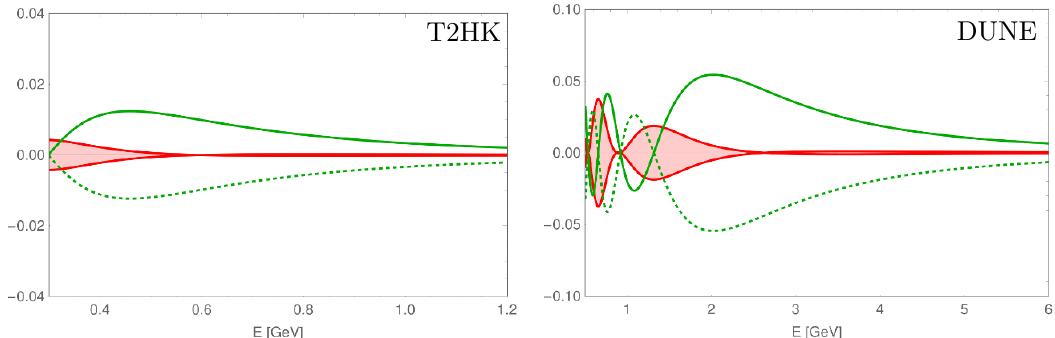
Figure 6 . Energy distribution of the two distinct terms of A CPT A CPT (green, (cid:14) -independent, hierarchy-odd) and A CPT (cid:0) T2HK L = 295 km (left) and DUNE L = 1300 km (right). Both Normal Hierarchy (solid) and In- verted Hierarchy (dashed) shown. The bands correspond to all possible values changing (cid:14) in (0 ; 2 (cid:25) ). Notice the di(cid:11)erent energy range and scale of the asymmetry between T2HK and DUNE plots.